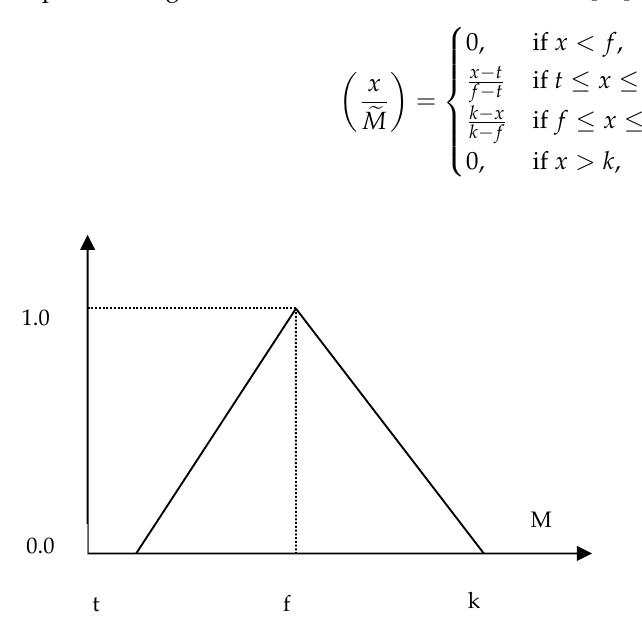
Figure 2. Triangular fuzzy number.